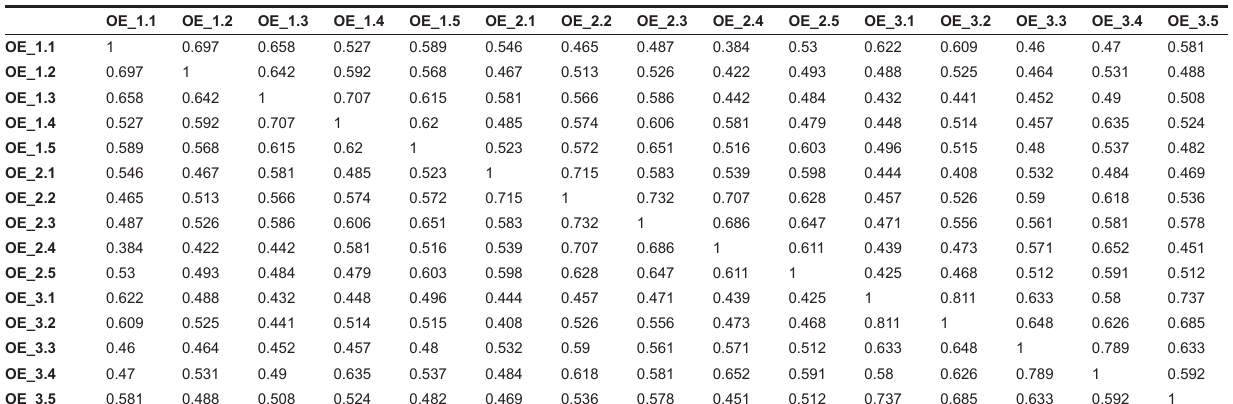
TABLE 2 Item intercorrelation (15 x 15) matrix of operational excellence